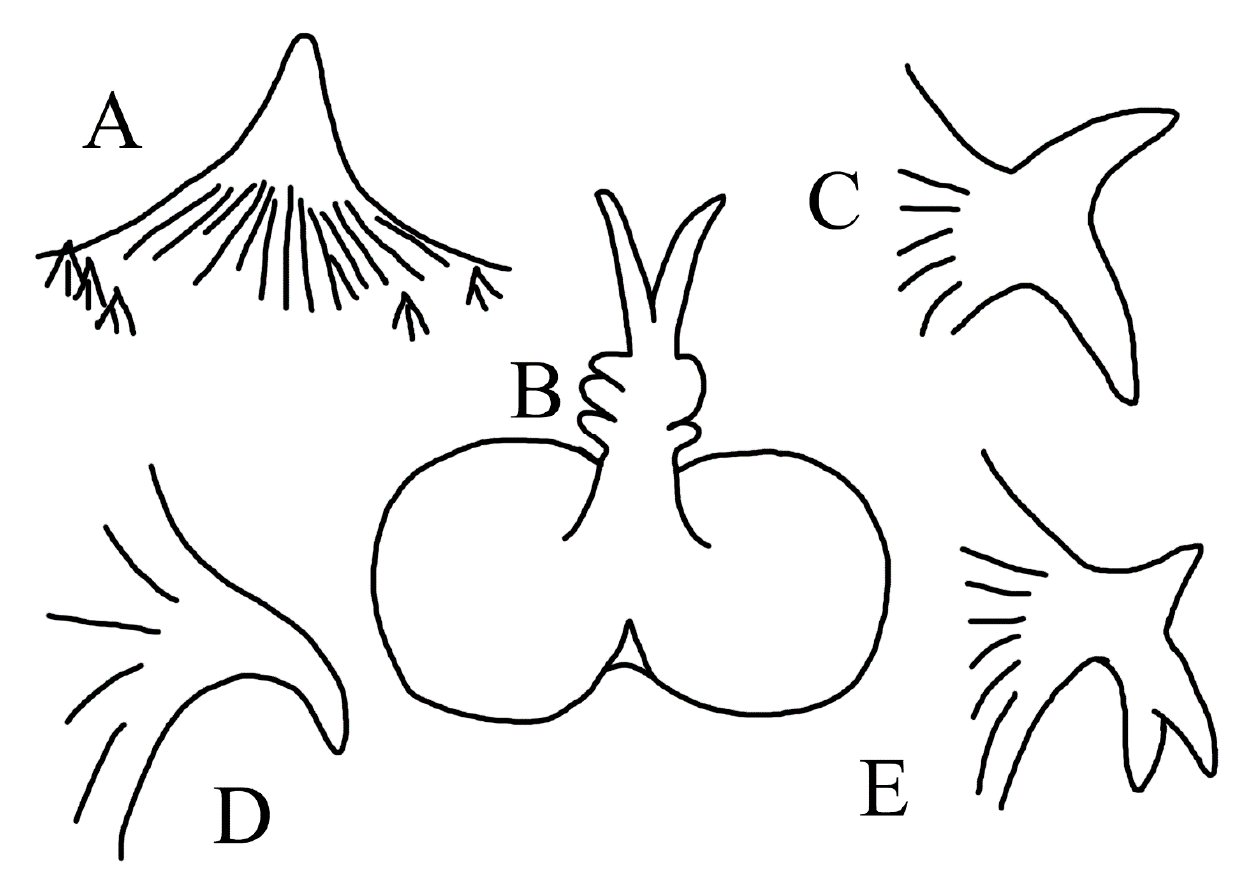
Figure 15. Esca and squamation of H. kawaii sp. nov., from holotype. ( A ) Rostral tubercle. ( B ) Esca. ( C ) Tubercle on disk margin. ( D ) Tubercle on tail. ( E ). Subopercular tubercle.